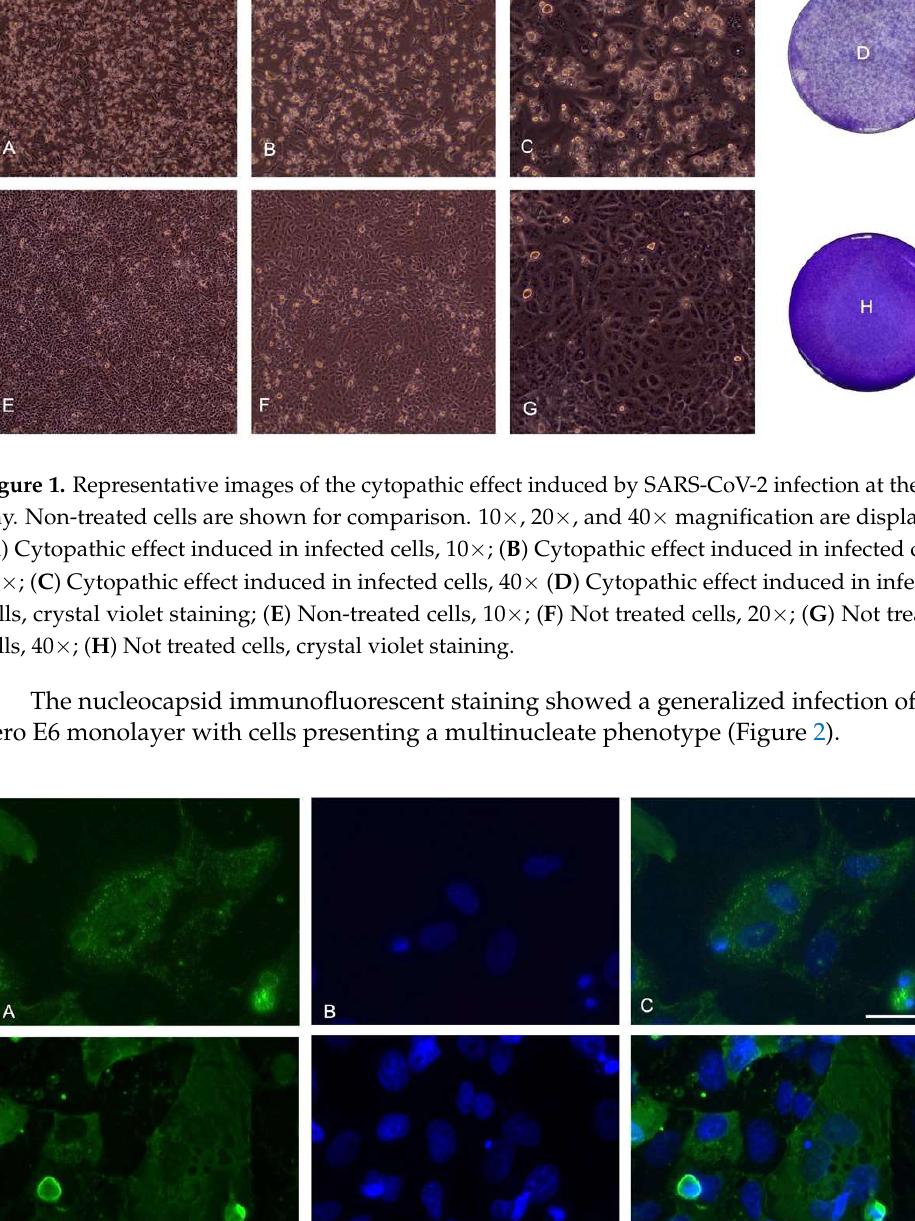
Figure 2. Representative images of the immunofluorescence assay for viral Nucleoprotein at the 7th day. 60 × magnifications are displayed (Z-stack, scale bar 30 micron). ( A , D ) Nucleocapsid (green); ( B , E ) Nuclei (blue); ( C , F ) Merge of the two channels.